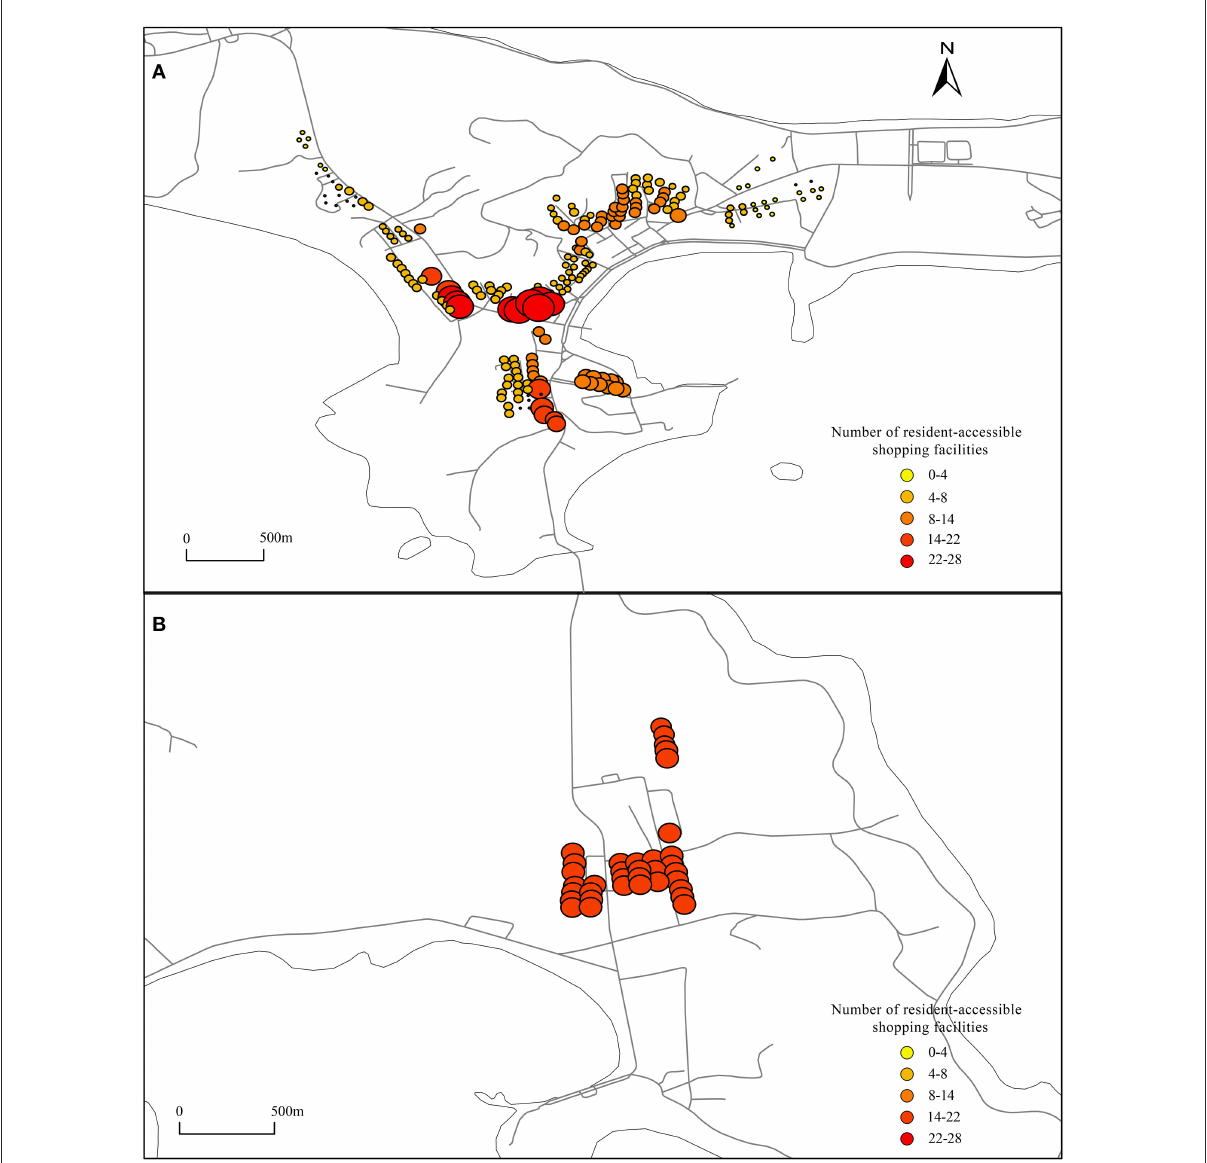
FIGURE9 Shopping facilities accessible to residents. (A, B) Using the UNA analysis tool, set the residential buildings as the starting point, shopping facilities as the ending point, import the road network, and calculate the number of shopping facilities that can be reached from residential buildings within a range of 800